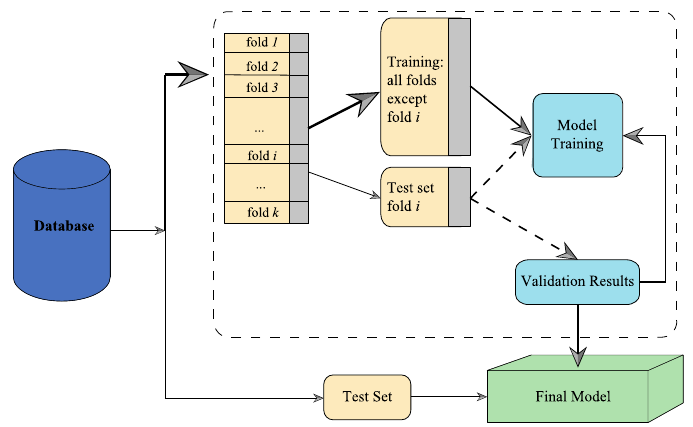
Figure 3. Methodology used for the development of the study.